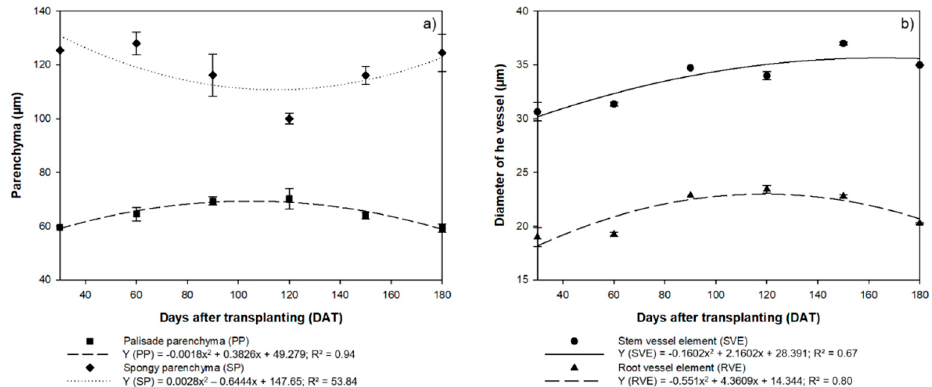
Figure 3. ( a ) Anatomical evaluation of the thickness of the Palisade Parenchyma (PP) and Spongiform Parenchyma (SP) of the seedlings of Hymenaea courbaril L. cultivated in the hydroponic system; ( b ) Diameter of the xylemic vessel elements in the stems (SVE) and roots (RVE) of the same plants. Sections obtained at 30-day intervals across the initial development of the plants (30, 60, 90, 120, 150, and 180 days after transplantation). Marker bars = SE (observed for eight repetitions).